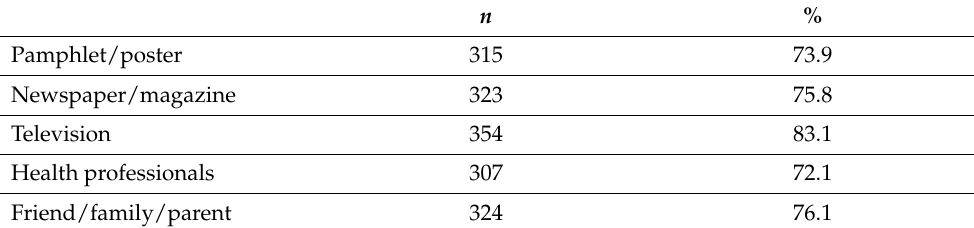
Table 5. Five of the most common information sources regarding salt reduction used by Hong Kong citizens ( n = 426).